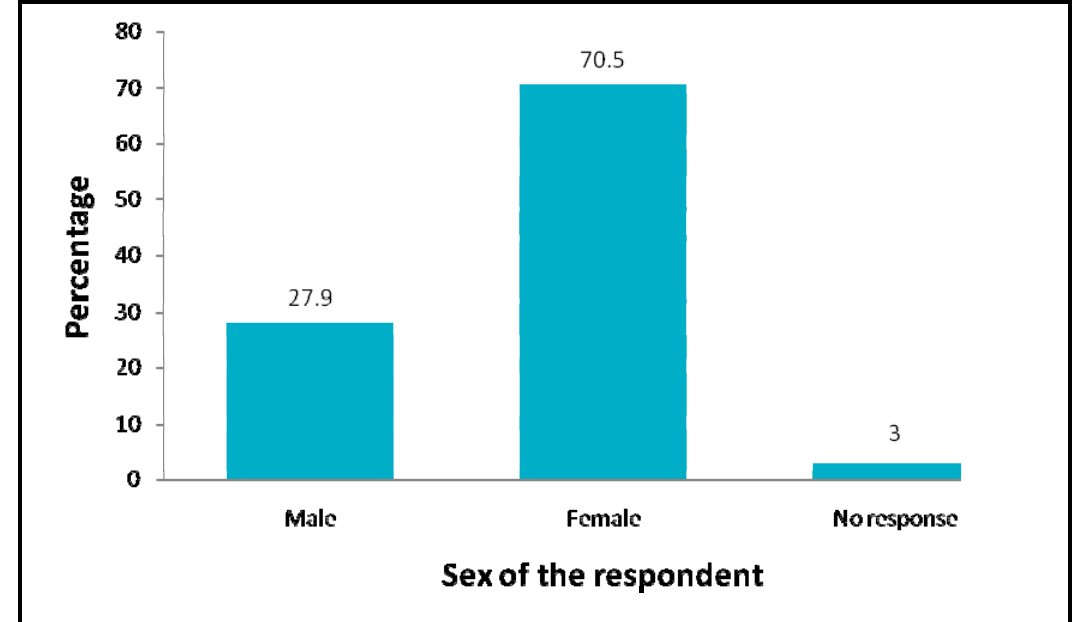
Figure 4. Gender percentage of respondents.